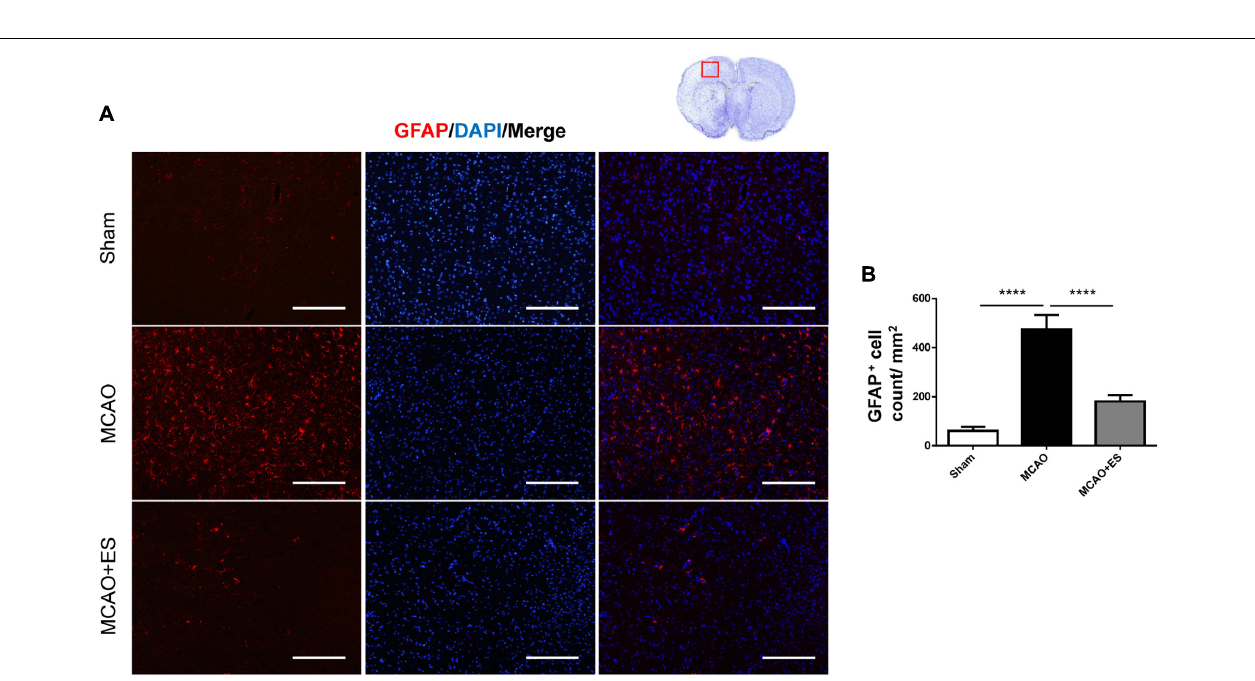
FIGURE 5 | Electrical stimulation treatment reduces the count of astrocytes in the MCAO animal model. Glial fibrillary acidic protein (GFAP) staining demonstrated that proliferation of astrocytes was suppressed by ES. (A) Immunofluorescence stains for GFAP (red fluorescence) and DAPI (blue fluorescence). The red blocked box in the top-right panel represents views in the penumbral region. (B) Quantitative analysis of immunoreactive cells (Sham n = 5; MCAO n = 10; and MCAO + ES n = 10). Scale bar = 100 µ m; **** p < 0.0001.